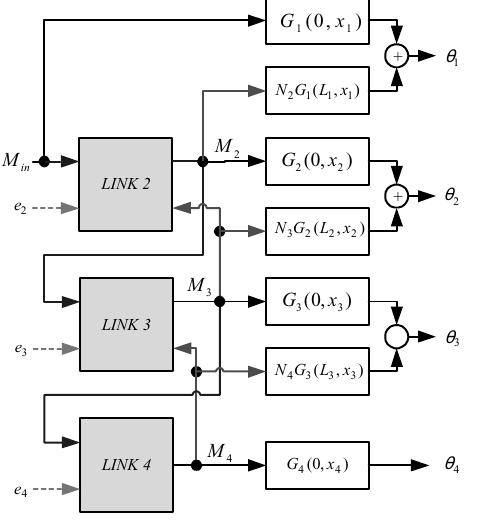
Fig. 10. Block diagram of a multi-link